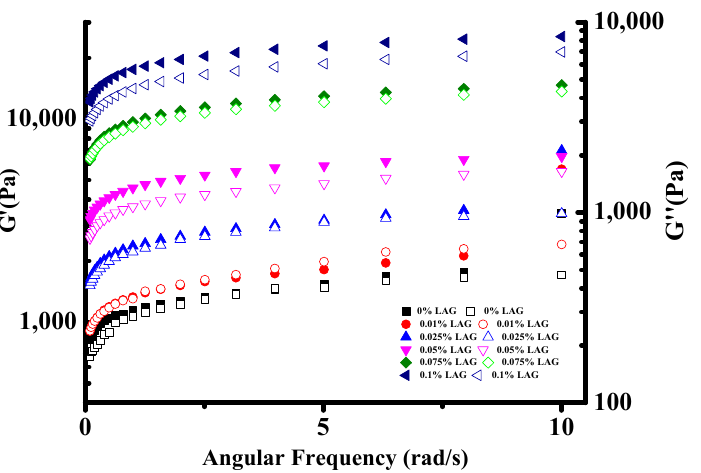
Figure 3. Frequency dependence of storage modulus G ′ and loss modulus G ″ for soy yogurt with different LAG contents.